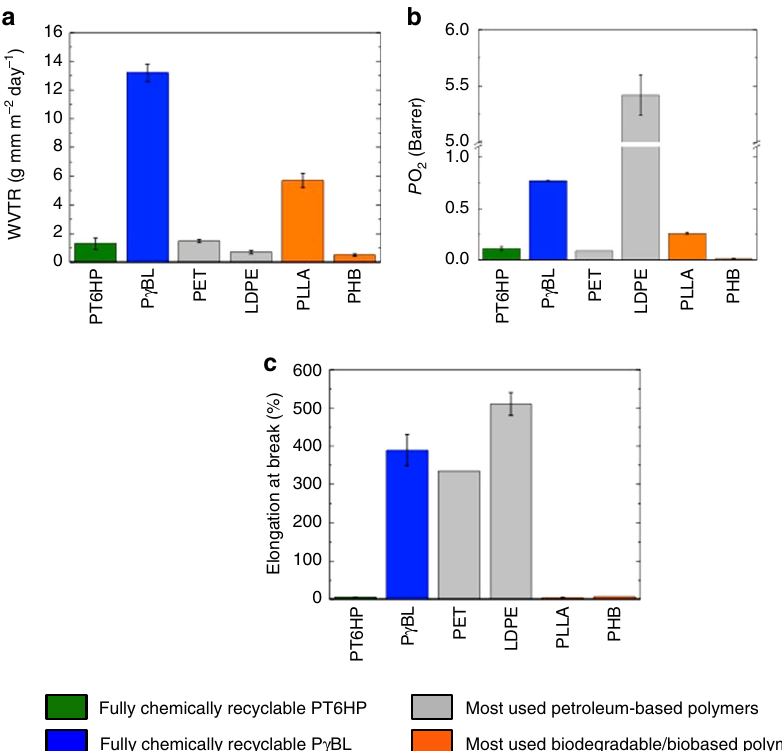
Fig. 1 Transport and mechanical properties. a Water vapor transmission rate of fully chemically recyclable PT6HP and P γ BL homopolymers and commercially available PET, LDPE and biobased/biodegradable PLLA and PHB. b Oxygen permeability coef fi cient of PT6HP, P γ BL, PET, LDPE, PLLA, and PHB. c Elongation at break of PT6HP, P γ BL, PET, LDPE, PLLA, and PHB. Error bars correspond to the standard deviation (s.d.) of at least four